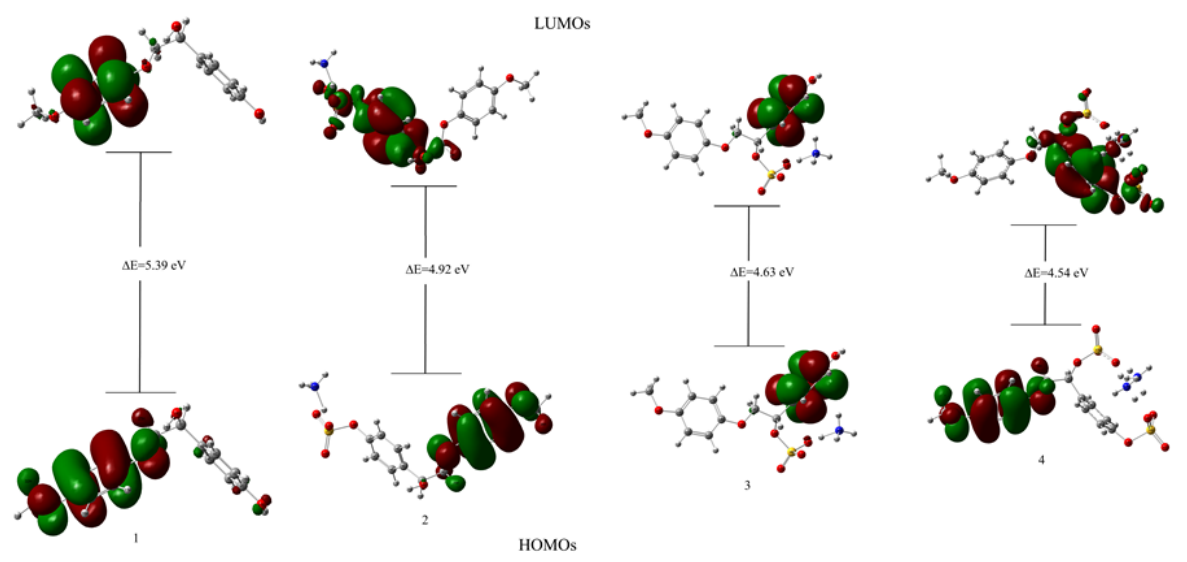
Figure 9. 3D representation of the HOMO–LUMO orbitals and their energies for the molecules under study.